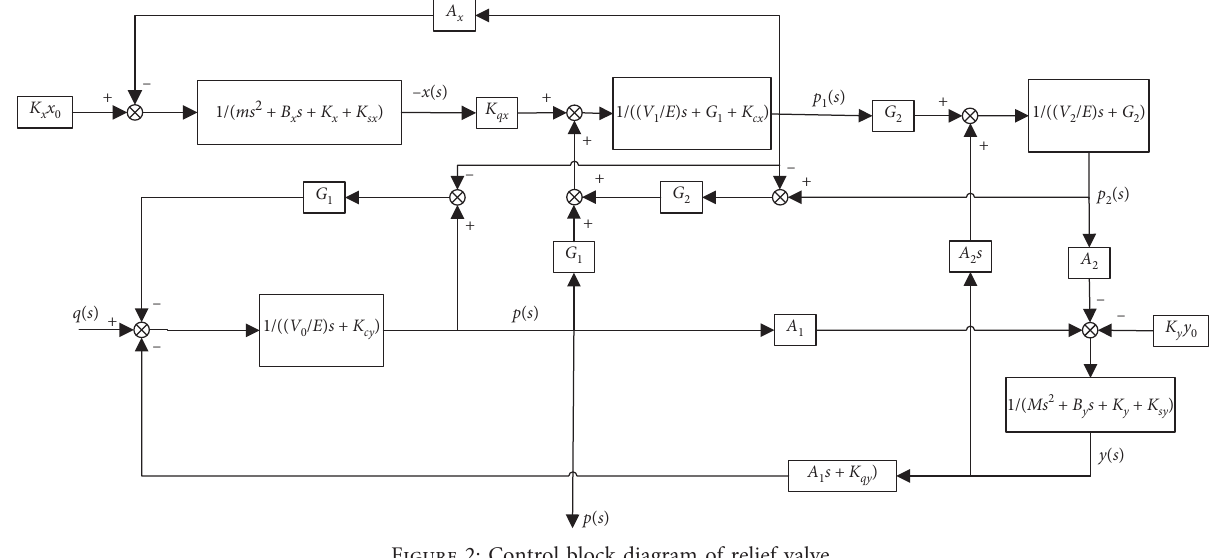
Figure 2: Control block diagram of relief valve.